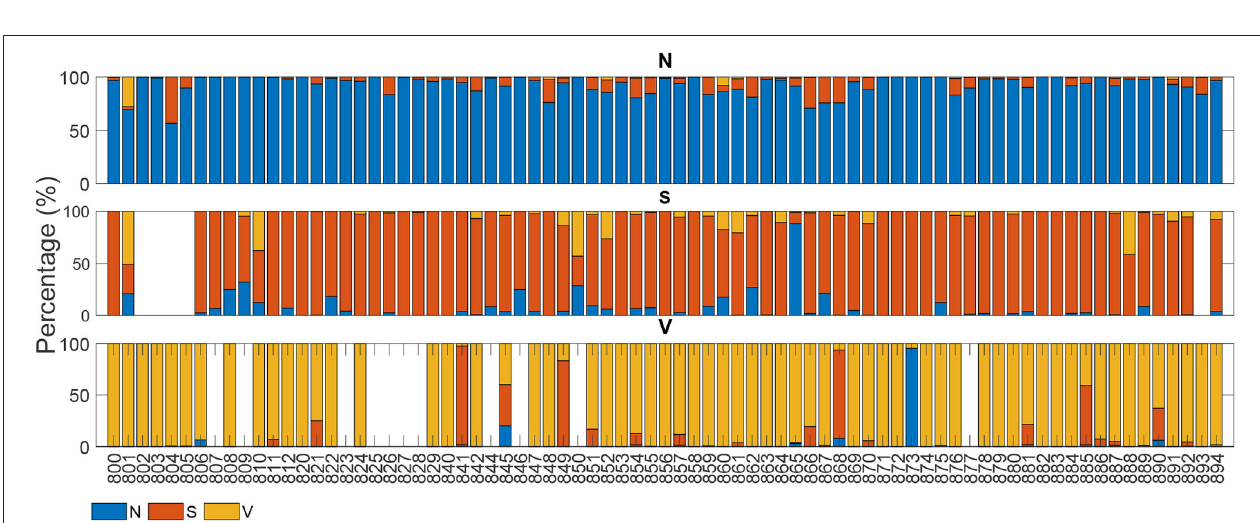
FIGURE 4 | Classification percentage of each of the LTSTDB signals’ beats. Each sub-graph represents the classification distribution of the beats of the three classes considered: N, S, and V. Each bar in each sub-graph represents the total number of beats of that class of a single patient and how they have been classified (in percentage). The x -axis represent the different patient IDs.